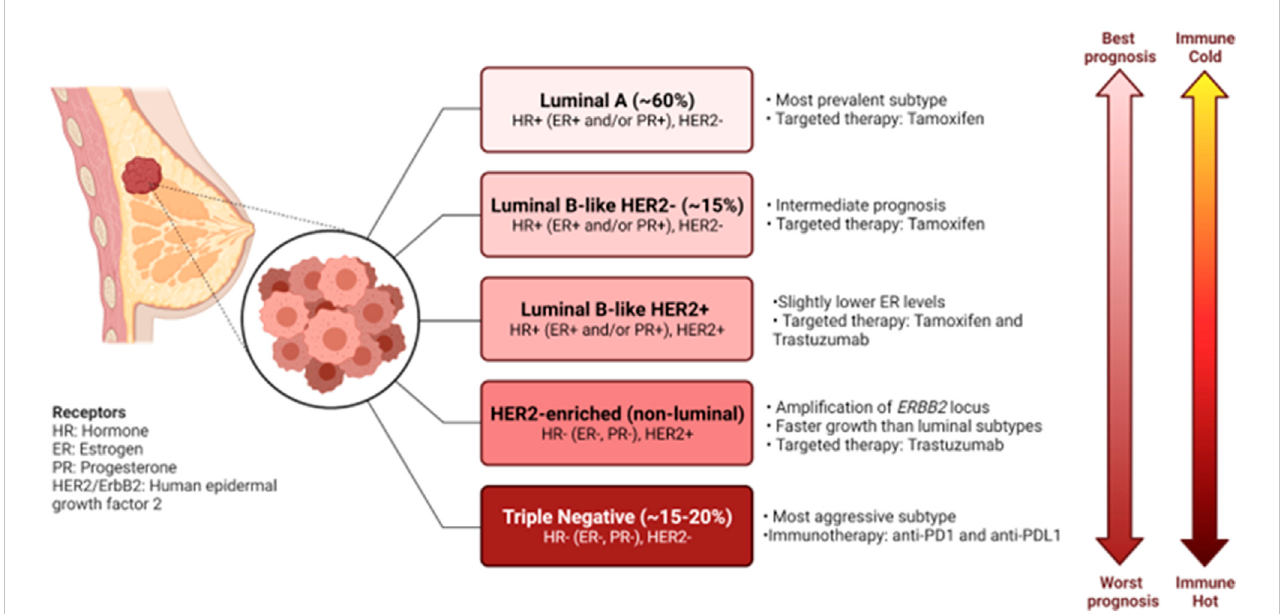
FIGURE 1 Characteristics of the molecular subtypes of breast cancer. Breast cancers can be classi fi ed based on gene expression pro fi les and receptor status. Each of the subtypes exhibit their own clinical manifestations, disease outcome, treatment options and various immune pro fi le. Figure generated with